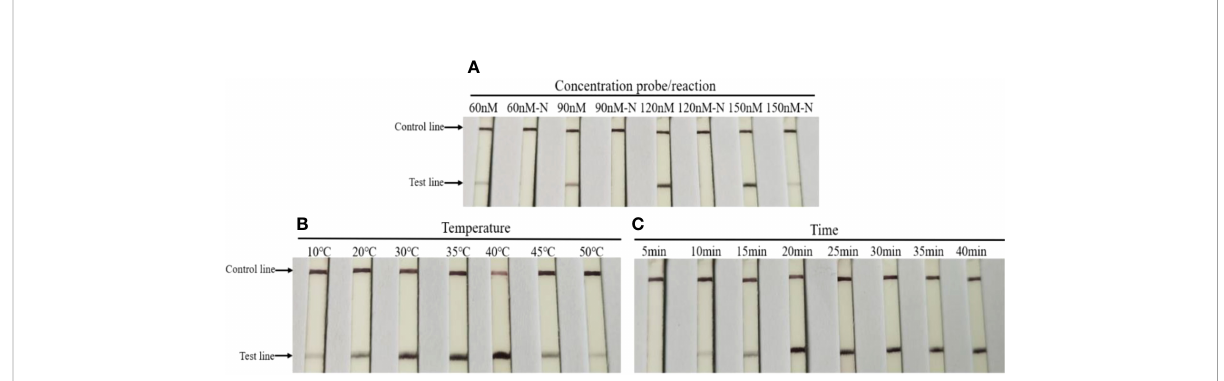
FIGURE 3 Optimization of the LFD-RPA detection assay. (A) Various concentrations of probe (60, 90, 120, and 150 nM) and no template control (60, 90, 120, and 150 nM-N) were evaluated using LFD-RPA. (B) Various reaction temperatures (10°C, 20°C, 30°C, 35°C, 40°C, 45°C, and 50°C) were used to select the optimal reaction temperature. (C) Various reaction times (10, 15, 20, 25, 30, 35, and 40 min) were used to select the optimal reaction time.